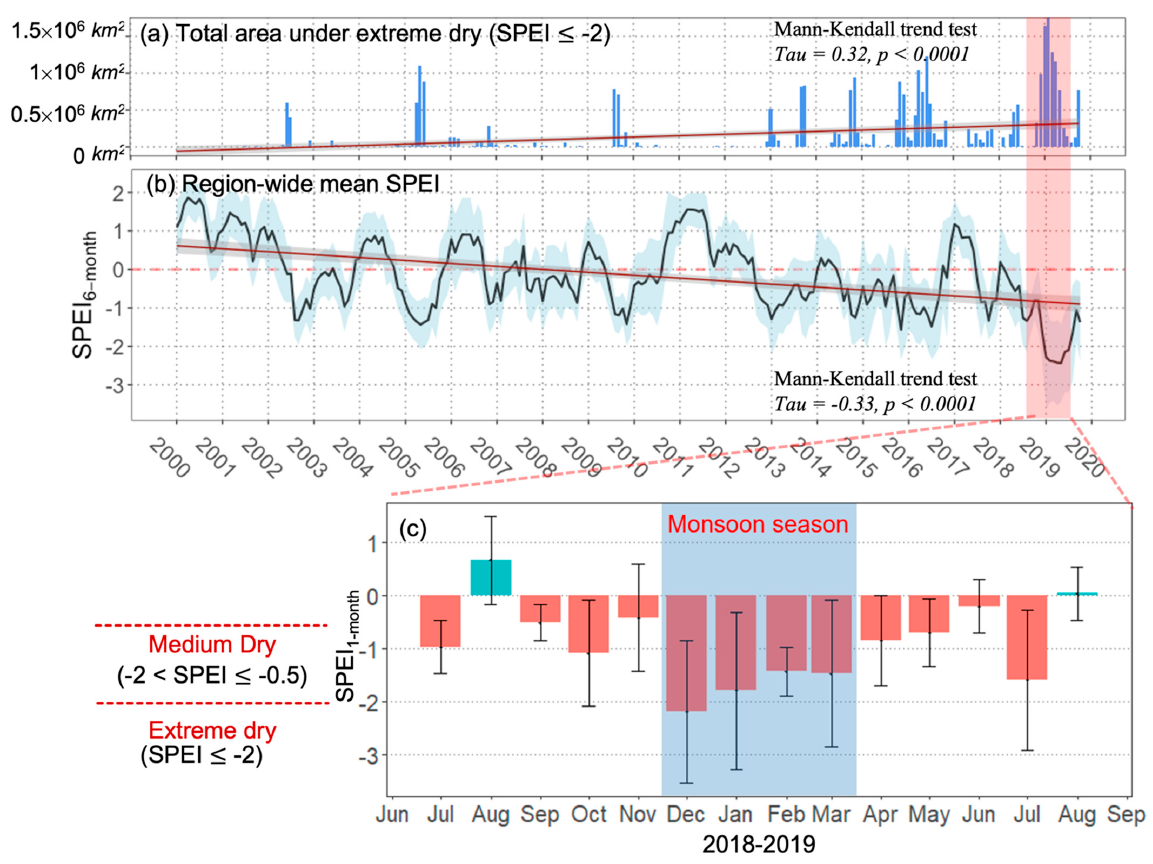
Figure 2. ( a ) Time series of the total area under extreme dry within the extent of study region during 2000–2019. Red line refers to the linear regression line. ( b ) Region-wide mean monthly SPEI 6-month during 2000–2019. ( c ) Region-wide mean monthly SPEI 1-month during 2018–2019.